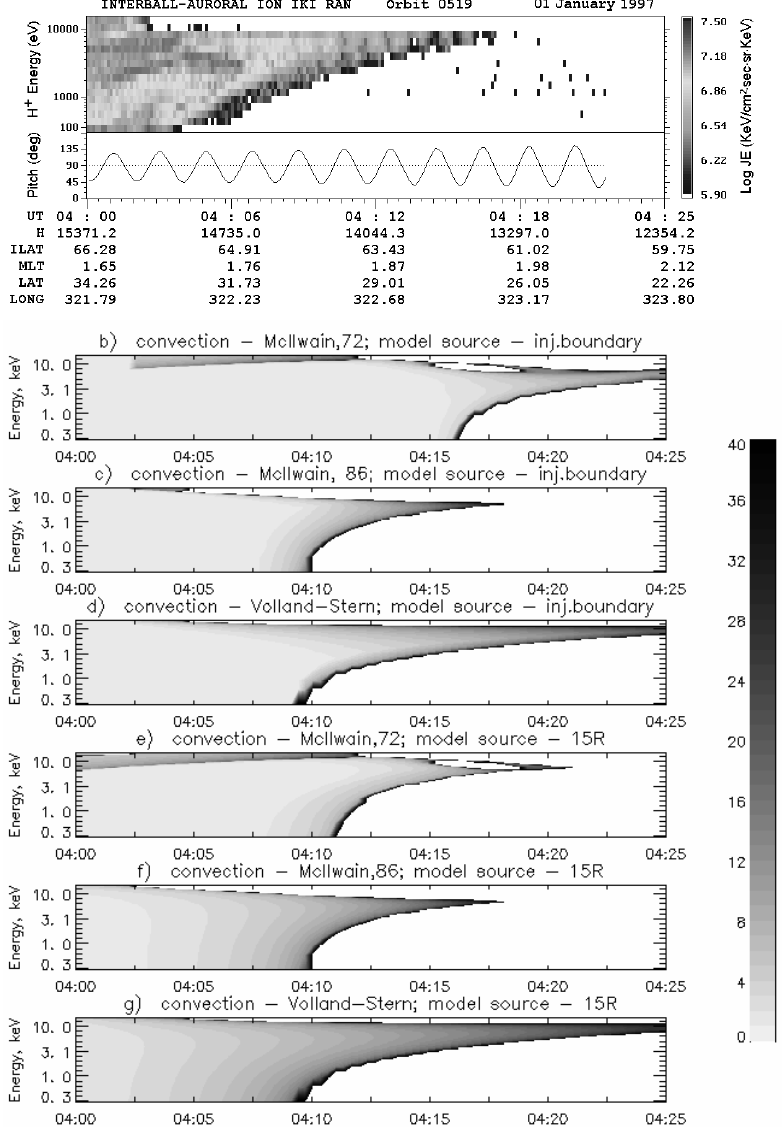
Fig. 10. Same as Fig. 7 for 1 January 1997 (orbit